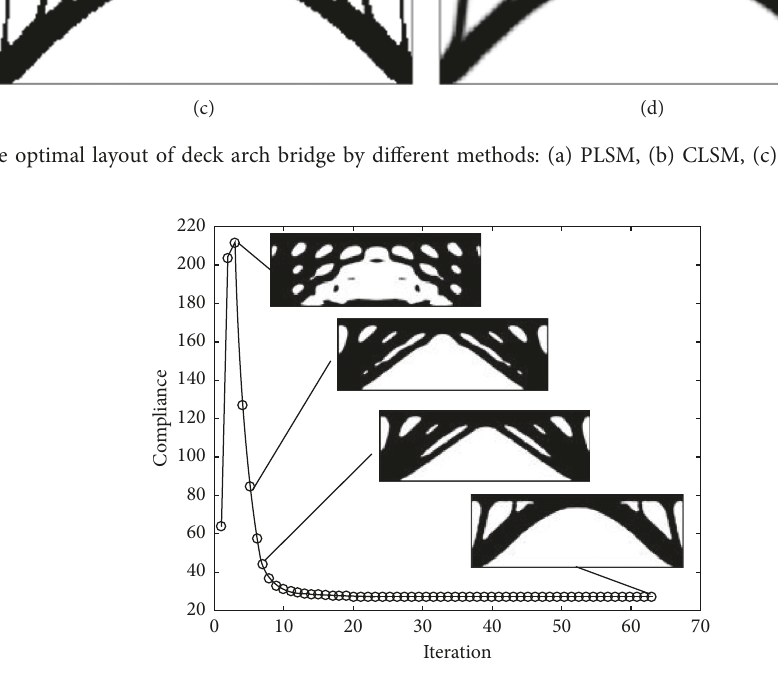
Figure 4: Iteration history of structural compliance for form finding of deck arch bridge.